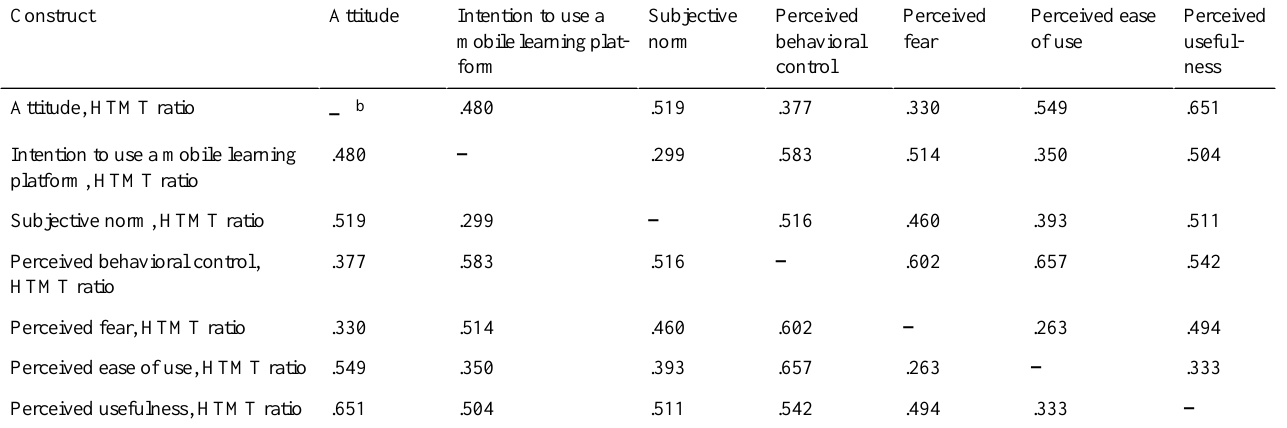
Table 6. HTMT a ratios of correlations between each construct.